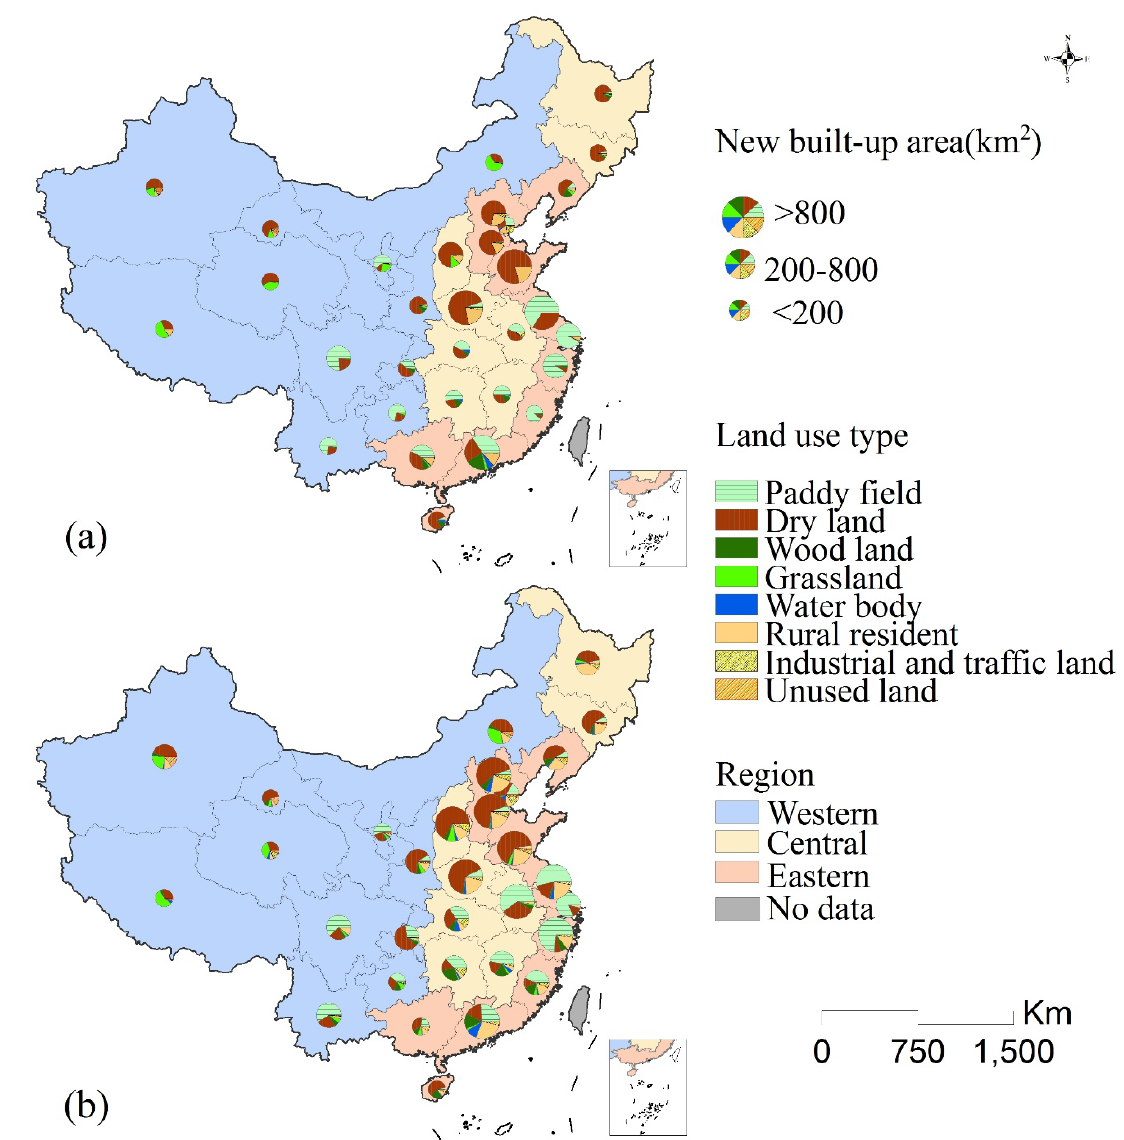
Figure 3. The source of new built-up areas at the provincial level in China in